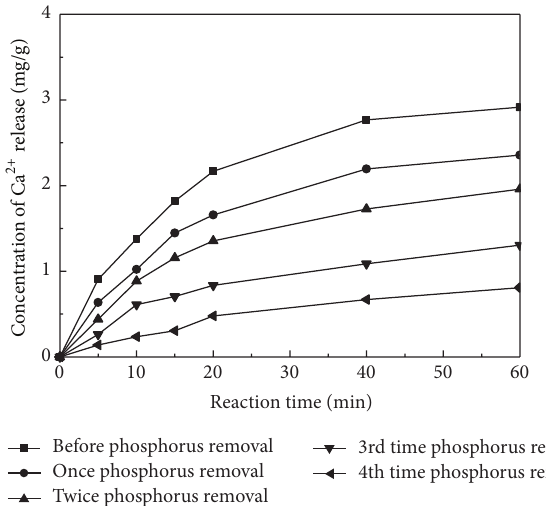
Figure 4: Concentration of Ca 2+ released from samples.